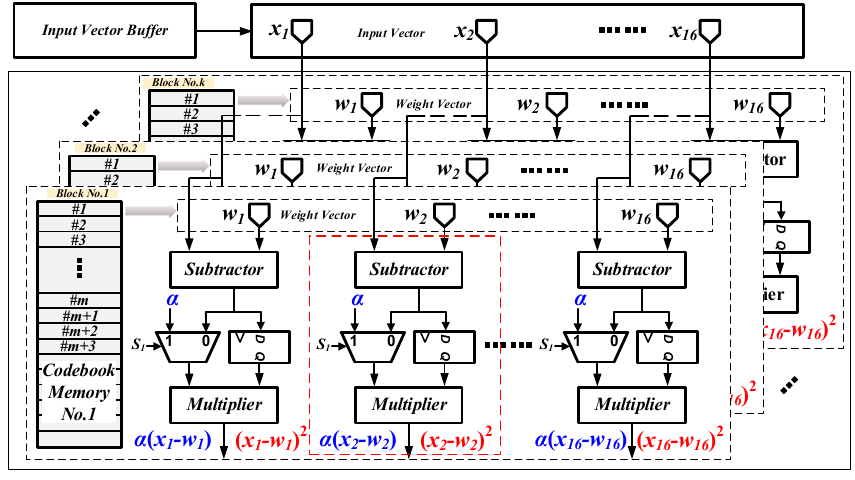
Figure 2. Block diagram of the squared difference unit and its related data flow.